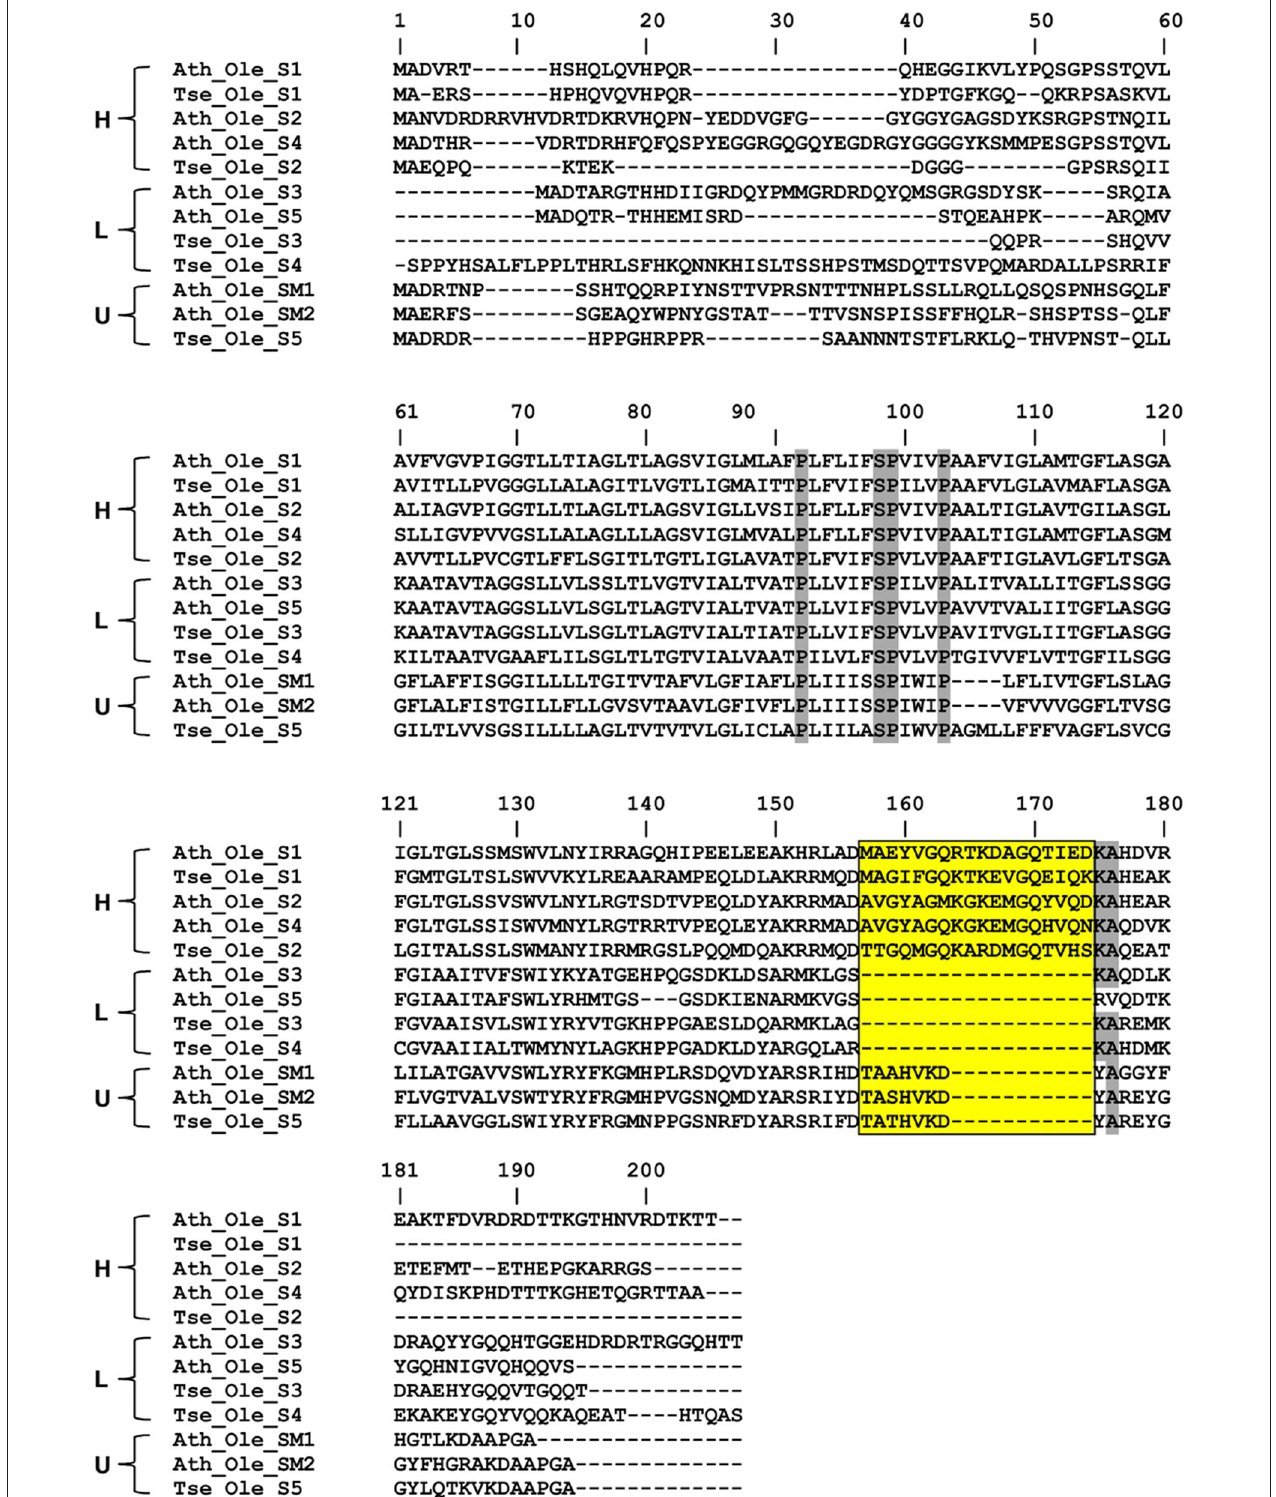
FIGURE 7 | Deduced amino acid sequence comparison of three oleosin isoforms (H, L, and U) derived from diverse plant species. The alignment was generated with ClustW program and then adjusted manually to optimize the alignment. Residues with highest conservation are highlighted with shade. The stretch of four invariable residues of the proline knot (PX 5 SPX 3 P) was also highlighted with shade while the insertion sites in the C- terminus of the H- Oleosin and U- Oleosin, relative to L- Oleosin, are boxed. Oleosins of the selected plant species are indicated with genus name, Ath ( Arabidopsis thaliana ), Tse ( Triadica sebiferum ).